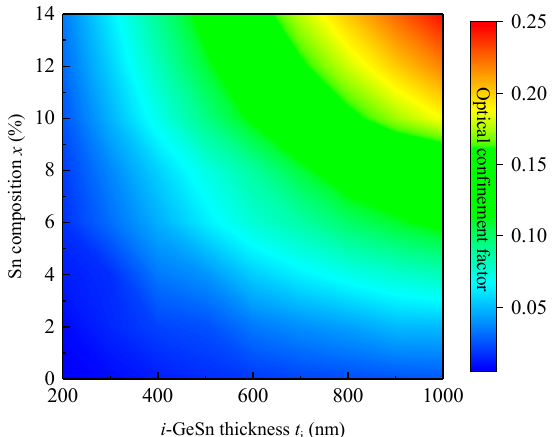
Figure 3. Simulated energy distribution for the quasi-transverse-electric fundamental mode of the GeSn WGPD for different Sn concentrations at λ = 2 µm.